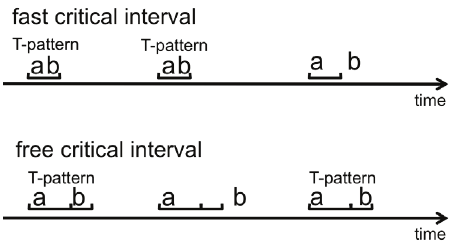
Figure 4. Event type temporal distributions within and outside fast and free critical intervals